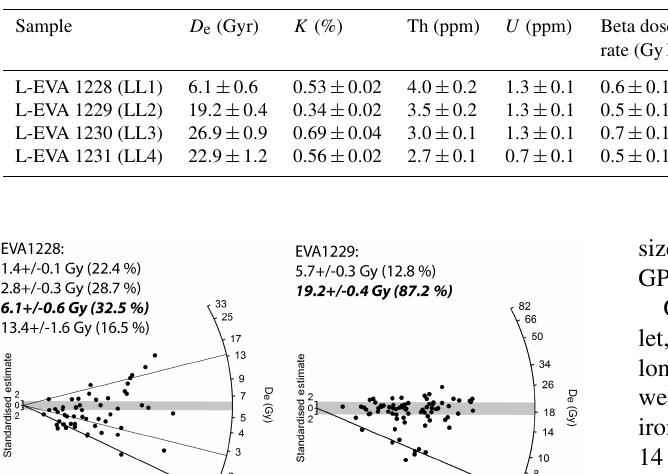
Table 1. Equivalent dose ( D e ), dose rate data, and OSL age estimates for Little Llangothlin Lagoon. Dose rates are listed as attenuated based on published factors (Stokes et al., 2003; Mejdahl, 1979).